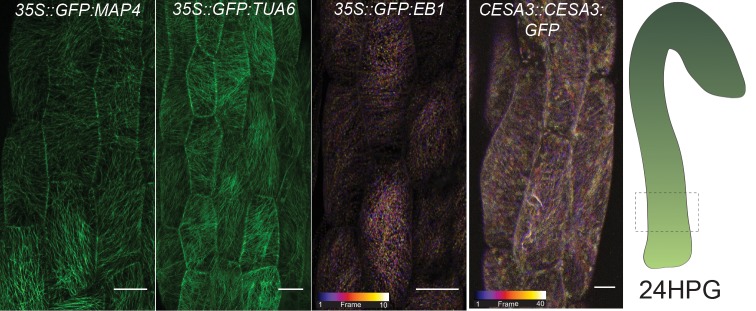
A wider selection of MT markers and CESA3 used for verification.(A) Microtubule markers and a cellulose synthase marker imaged from bottom cells at 24HPG; outer epidermal face. The markers show similar patterns in microtubule alignment, that is little alignment, to the GFP-MAP4 images in Figure 2. Both EB1 and CESA images are temporal color-coded projections of an xytz acquisition at the base of the hypocotyl with 10 stacks over 4 min 41 s for EB1 and 40 stacks over 9 min 49 s for CESA3; these are dynamic markers. Scale bars = 10 µm.